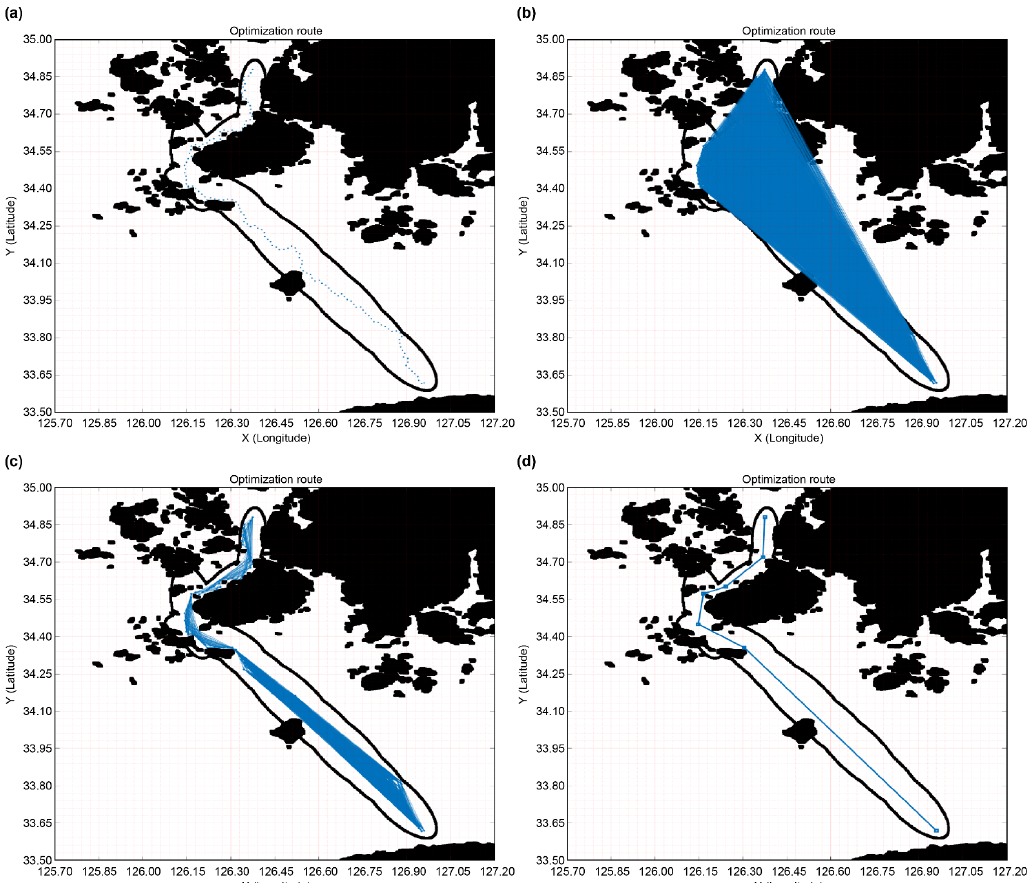
Figure 25. The route optimization process: ( a ) The final route derived in Case 1 consists of 67 nodes, ( b ) generate undirected graph by inter-connecting all nodes, ( c ) searched collision-free space graph between the graph and obstacles area, and ( d ) The result of applying Dijkstra’s algo ‐ rithm to the collision ‐ free space graph.